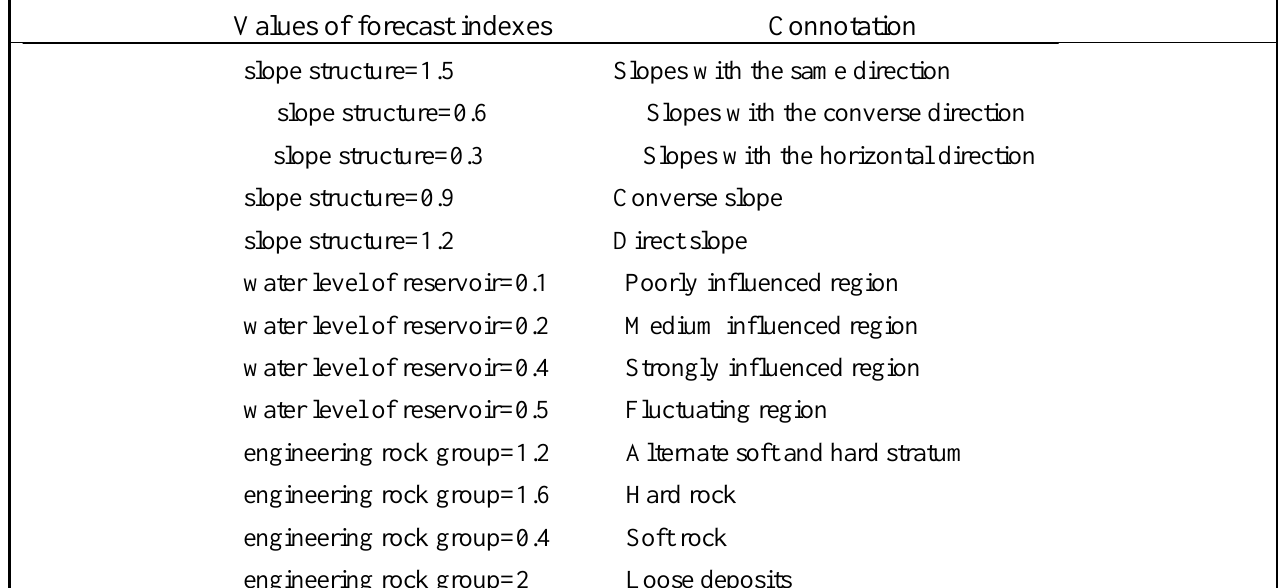
Table 3. Connotation of the values of the forecast factors.